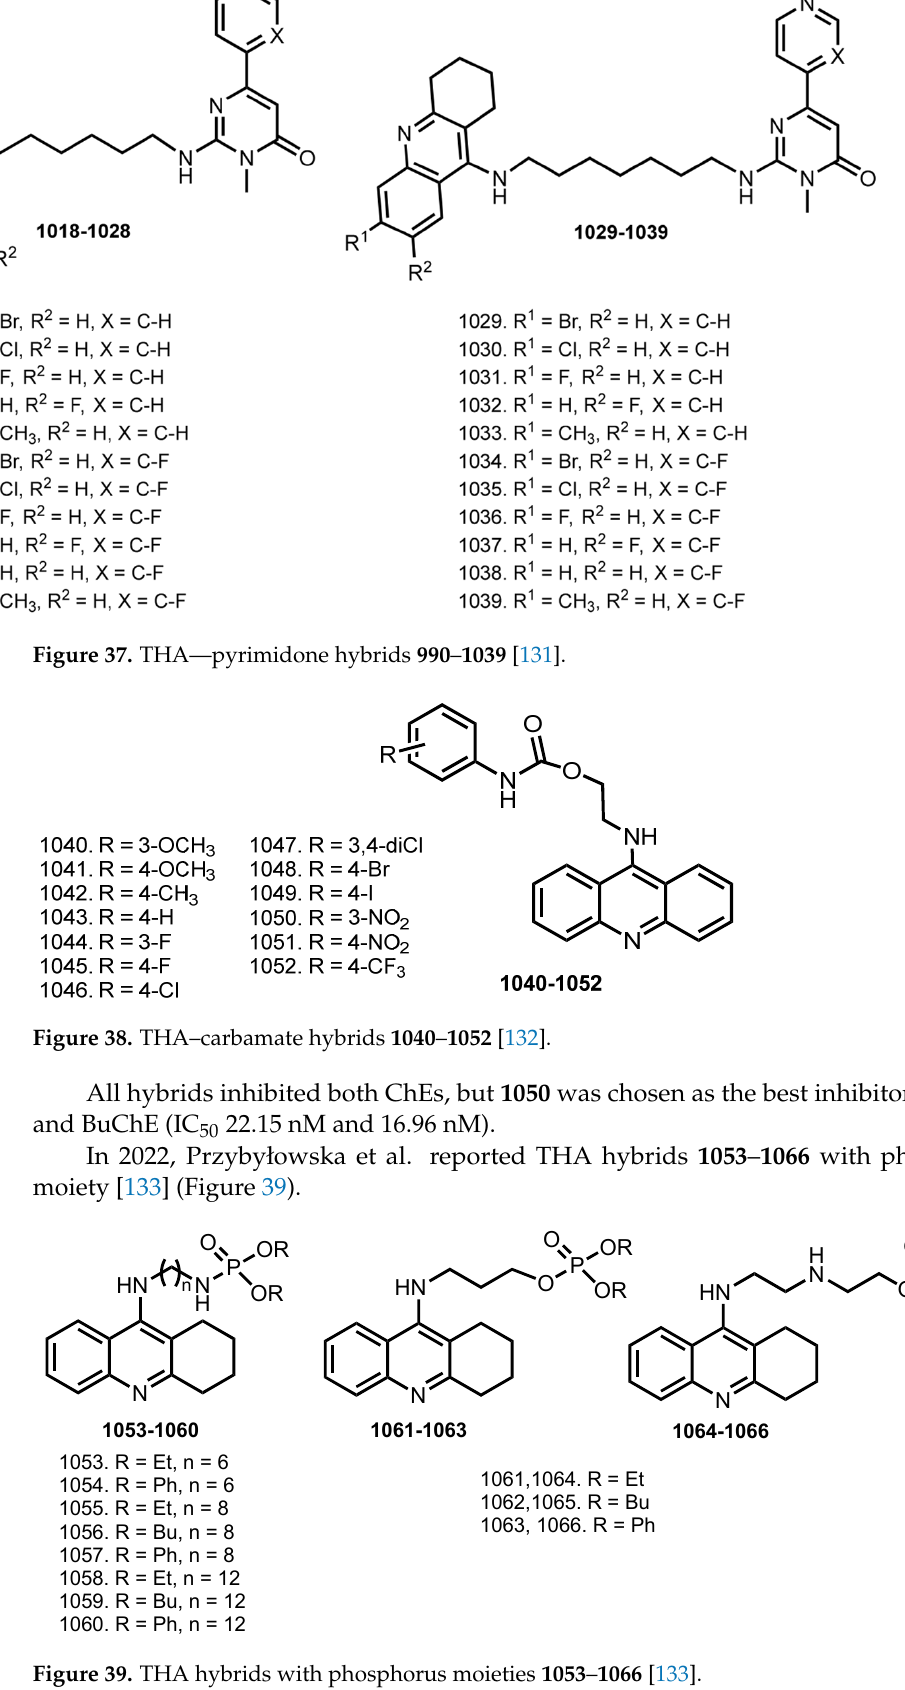
Figure 36. 7 ‐ MEOTA ‐ p ‐ anisidine hybrids 945 – 958 [128], THA ‐ 1,2,3 ‐ triazole hybrids 959 – 973 [129], Schiff base hybrids 974 – 989 [130].